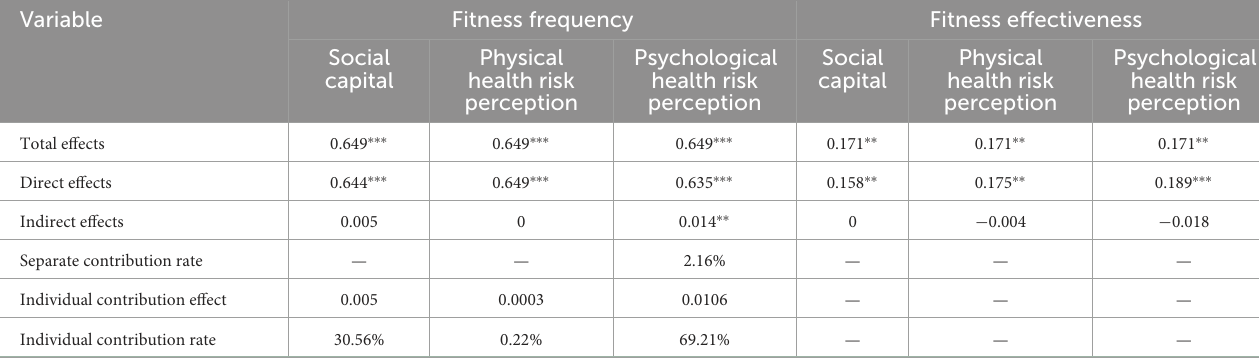
TABLE 4 Mediating effects test based on the